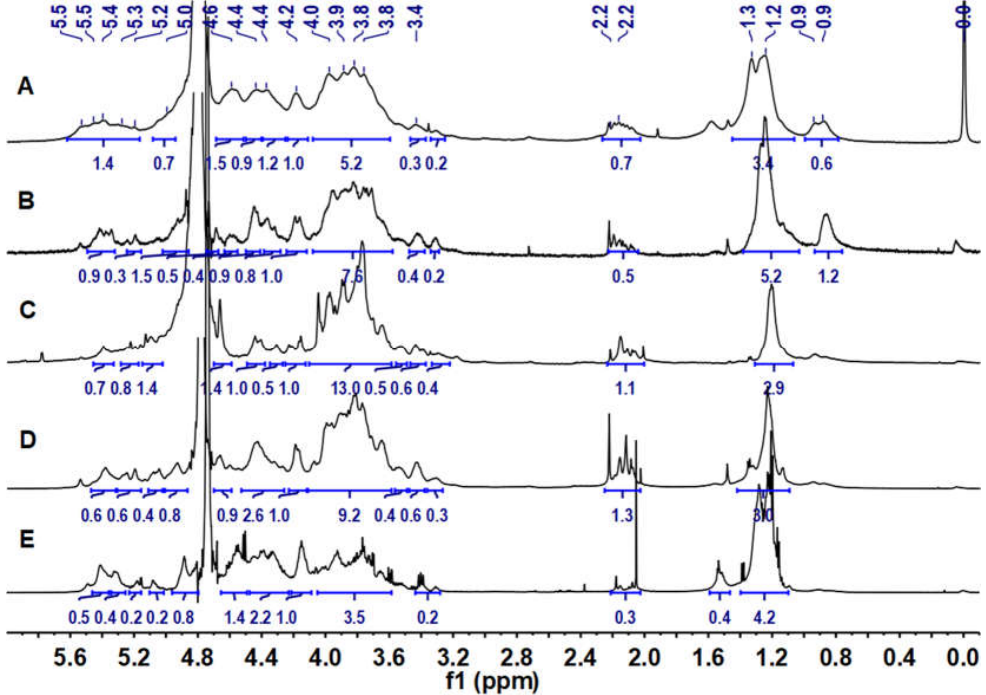
Figure 2. 1 H NMR spectra of LJPs ( A ), LJP0 ( B ), LJP04 ( C ), LJP06 ( D ), and LJP08 ( E ).